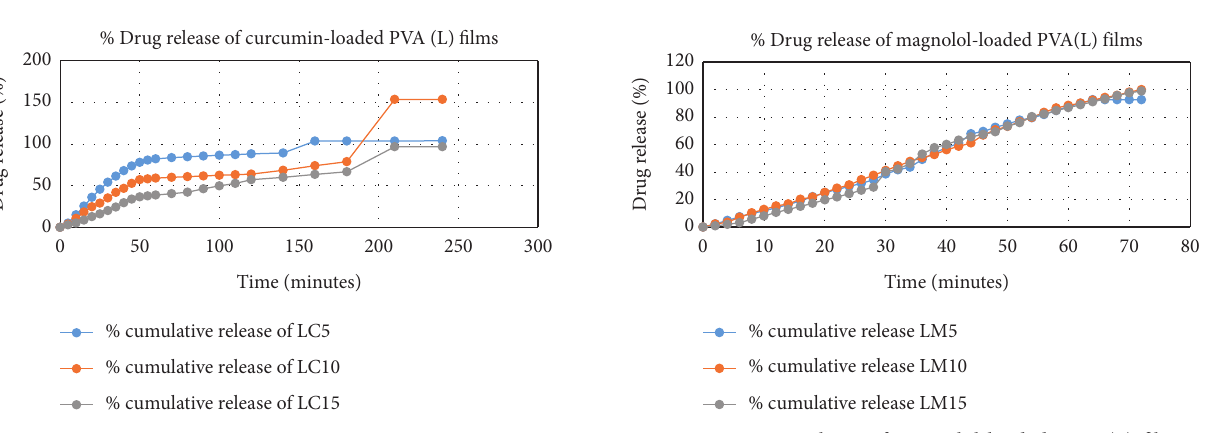
Figure 12: Drug release % of curcumin-loaded PVA (L) films.